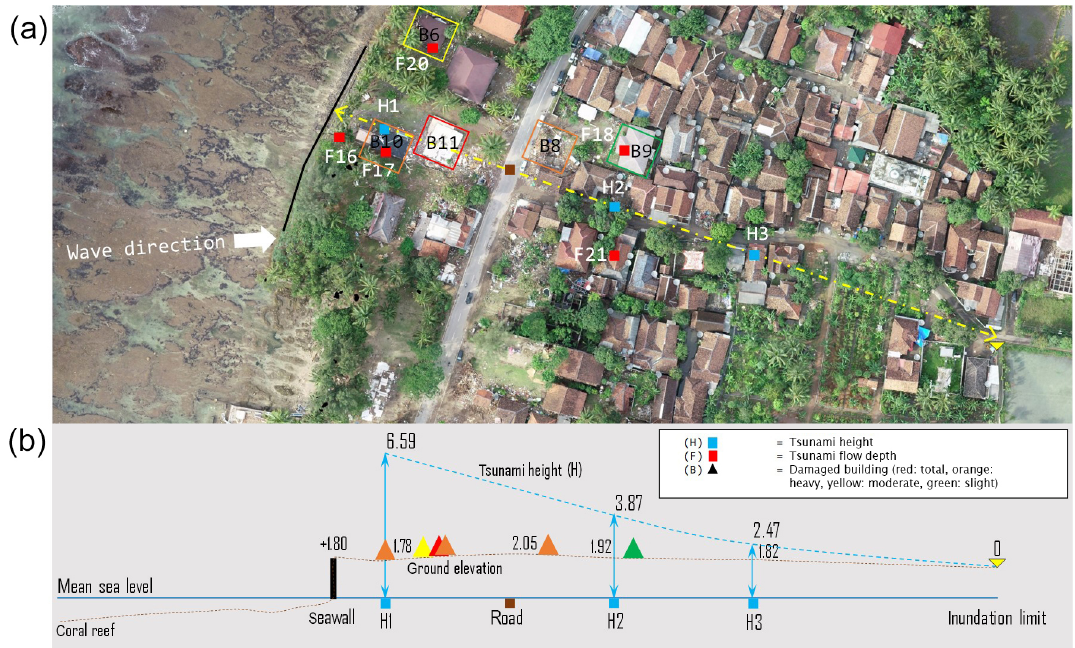
Figure 5. A cross profile of tsunami height in Suka Ramai, Carita, Banten. Panel (a) is the location of the transect plotted on an aerial image captured on 28 December 2018.